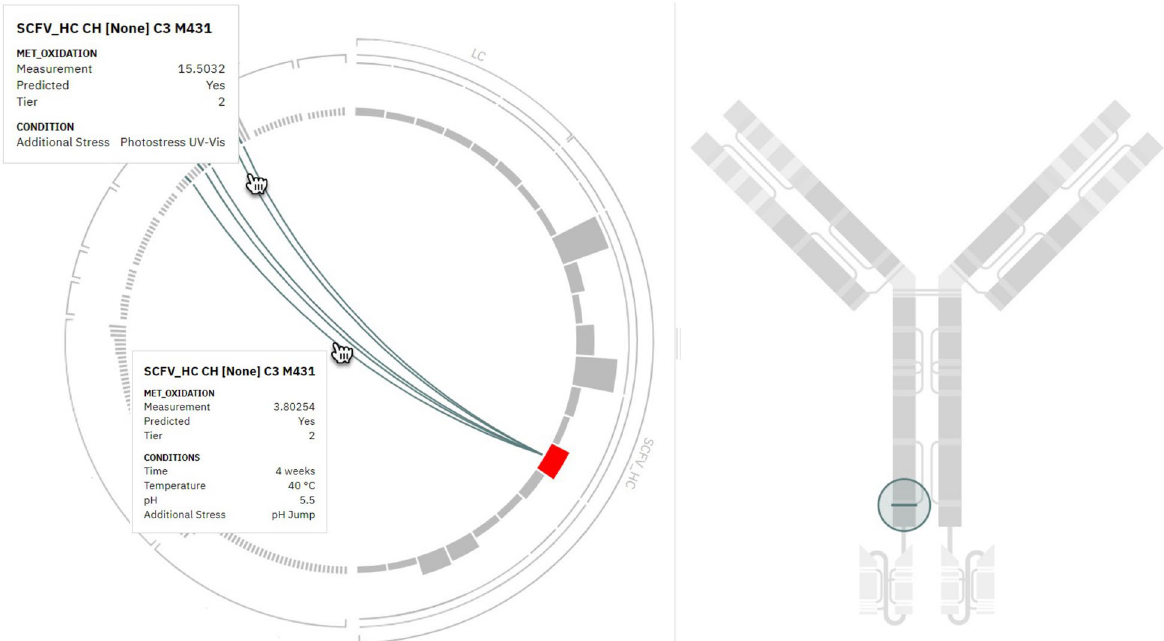
Fig. 13 Experimental property data are correlated to one-dimensional amino acid sequence positions in the radial graph and the two-dimensional location on